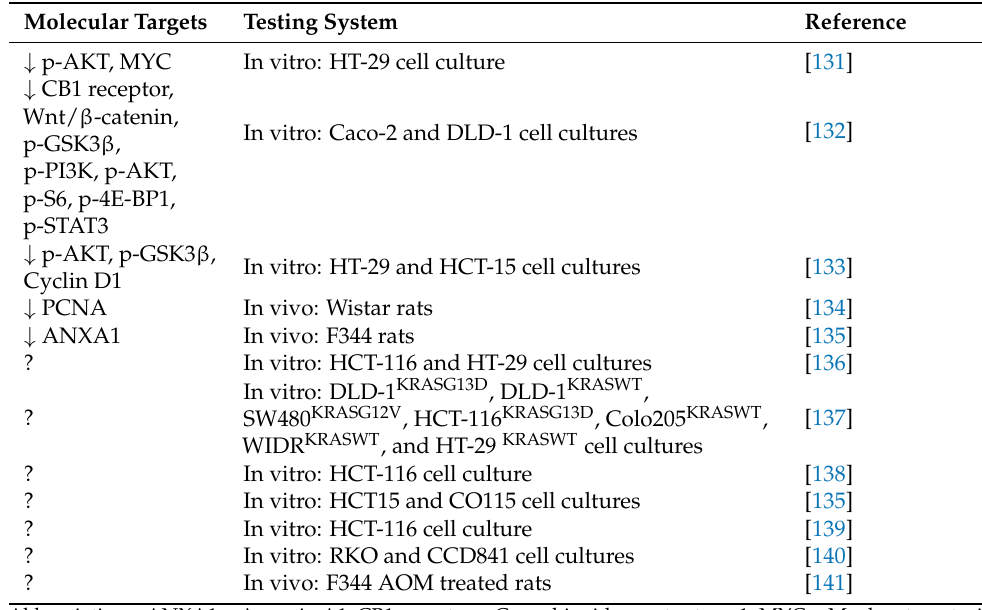
Table 3. Reported targets of quercetin active in the reduction in cellular growth and proliferation of CRC models alongside their in vivo/in vitro testing system. “ ↓ ” arrows are indicating the downregu- lation, while “?” denotes the lack of specific targets in the respective